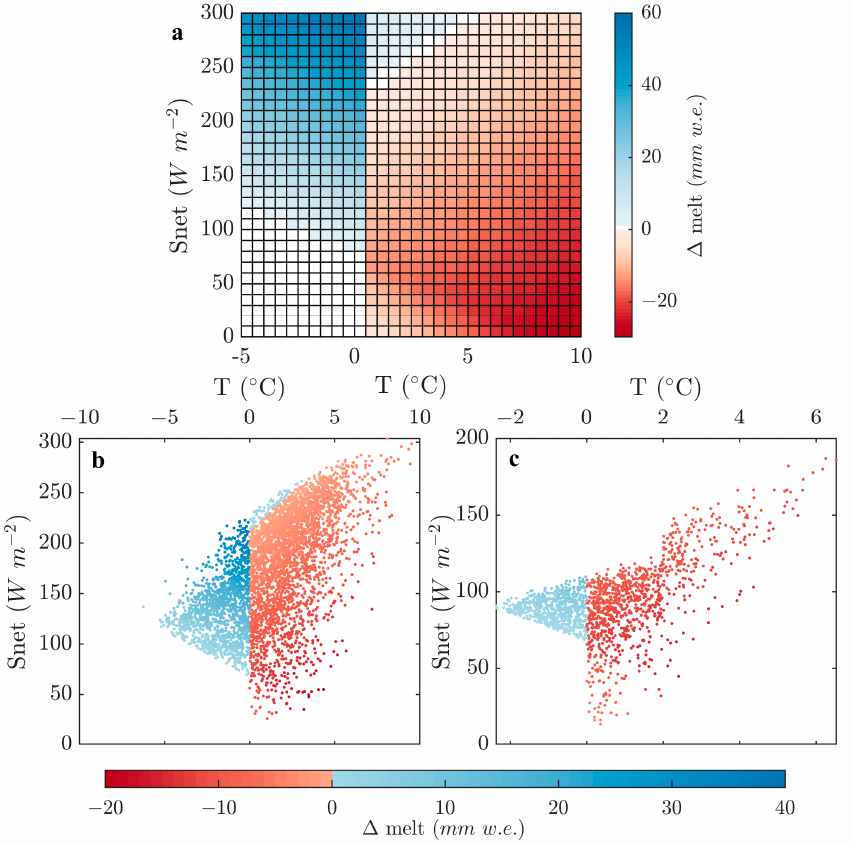
Figure 12. ( a ) Melting difference between SEBM and ETIM at different combinations of temperature and net shortwave radiation, ( b ) melting difference at 4300 m a.s.l., and ( c ) melting difference at 5000 m a.s.l., ∆ melt = melt_SEB − melt_ETI, and a positive (negative) value shown in blue (red) means that the SEBM (ETIM) simulates more